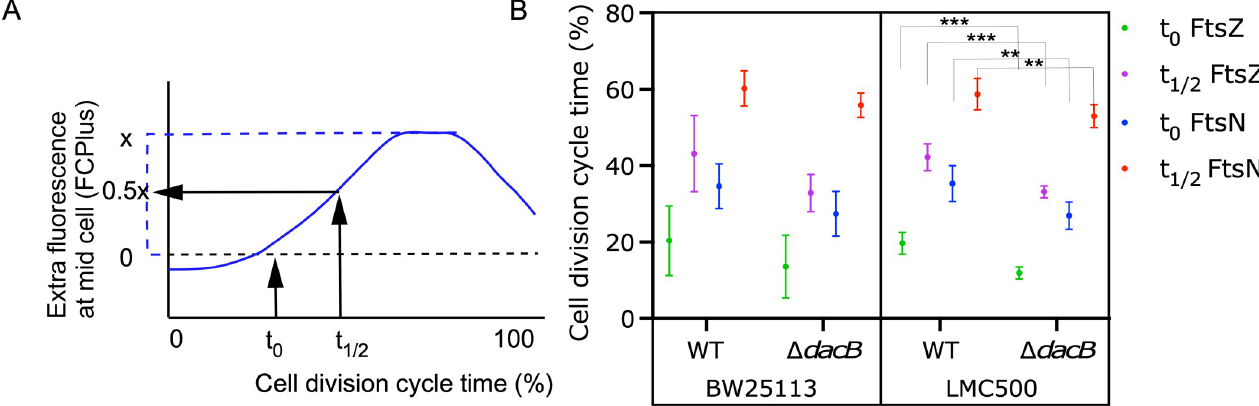
Fig 6. The absence of PBP4 advances divisome assembly. Cells were grown in minimal glucose medium to steady state at 28˚C, fixed and immunolabeled against FtsZ and FtsN. (A) Graphical illustration of the meaning of t 0 and t 1/2 . (E). Cell division cycle age timing of FtsZ and FtsN for the Δ dacB strain (10 and 6 replicates, respectively) and its parental BW25113 (7 and 6 replicates, respectively) and the Δ dacB strain (6 and 6 replicates, respectively) and its parental LMC500 (13 and 12 replicates, respectively). Using an unpaired T-test: P 0.0001 = ��� , P 0.001 = �� .